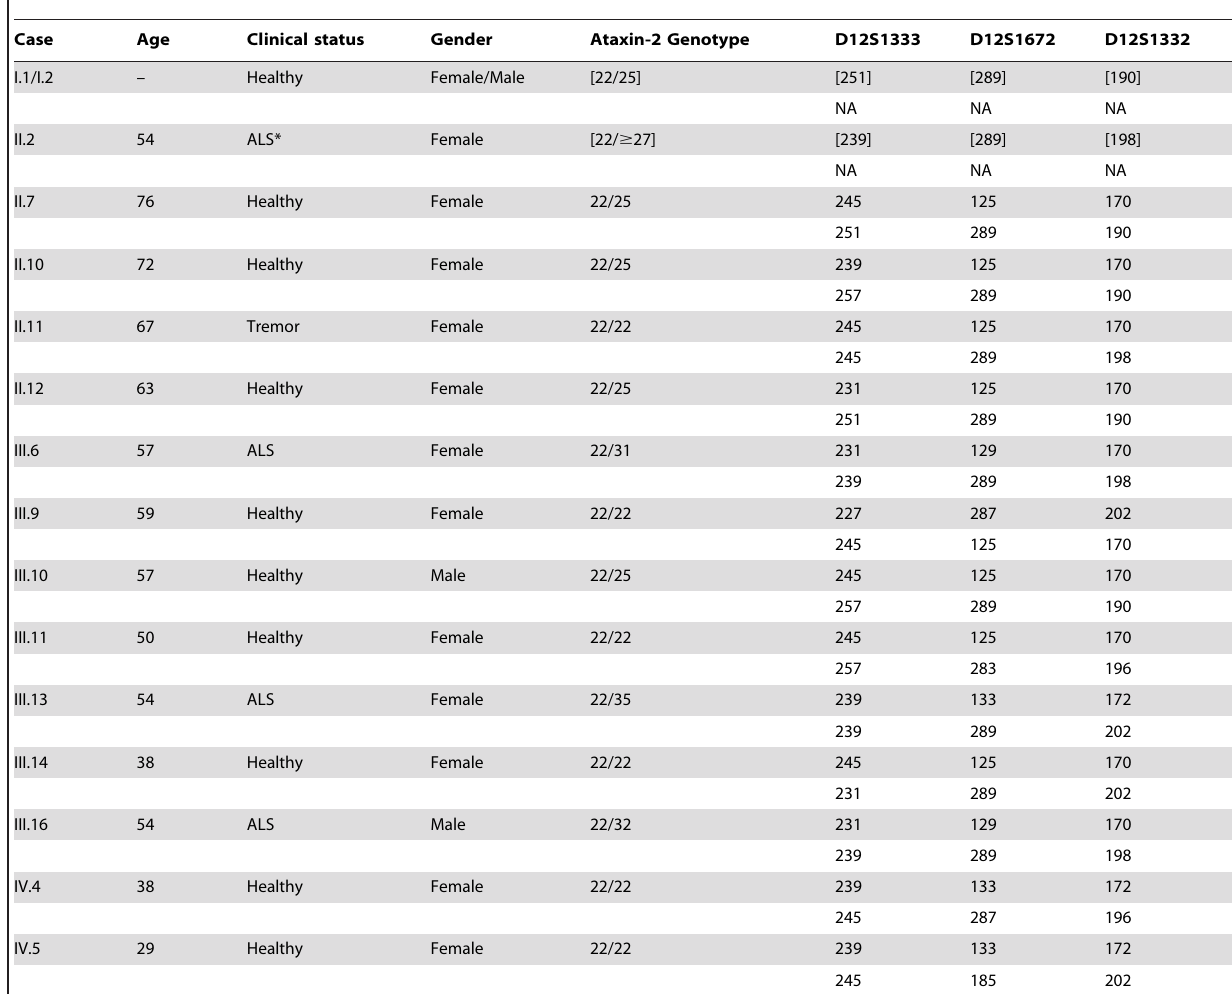
Table 1. Phenotype and ATXN2 genotype for ALS case